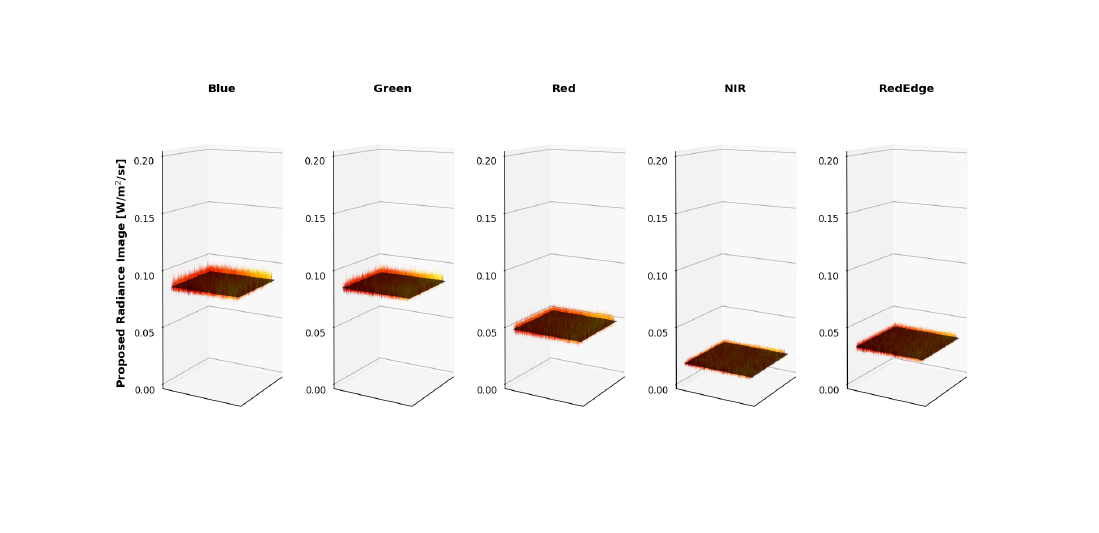
Figure 20. Example proposed radiance imagery shown as 3-D images. ASD reference is shown as a black 2-D image. Using the proposed methodology, the produced radiance imagery magnitudes line up with the ASD reference and the applied vignette correction flattened the